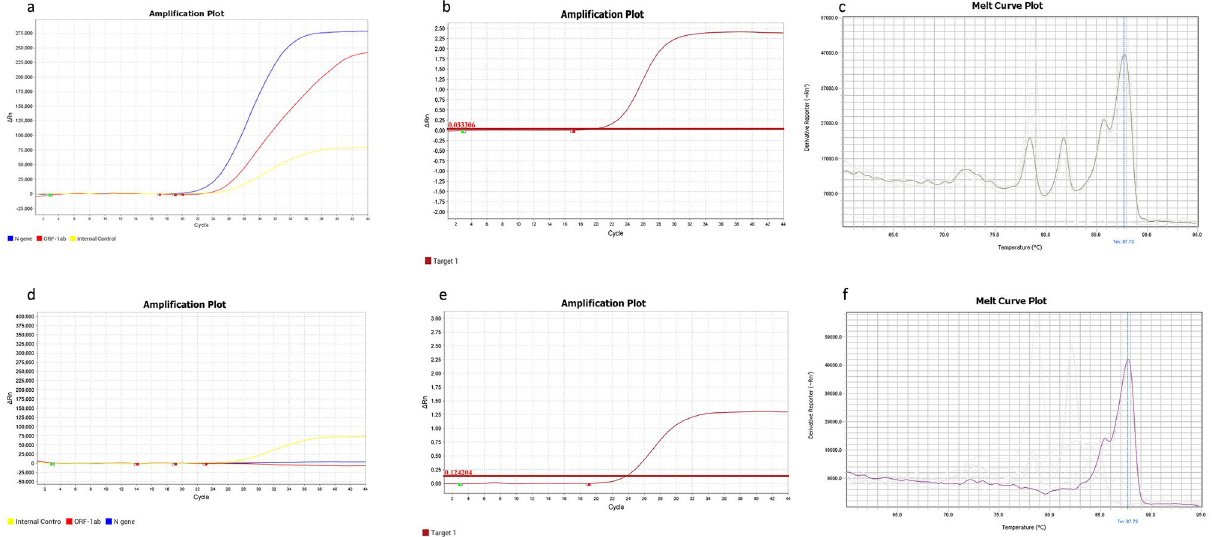
Figure 4. RT-PCR results for both assays. ( a ) Positive result for TaqMan Based method; ( b ) positive result for N, E and β-Actin genes in SYBR Green Based Method (linear View of fluorescence); ( c ) positive result for N, E and β-Actin genes in SYBR Green Based Method (Melt curve plot) ( d ) negative result for TaqMan Based method (only Internal control peak); ( e ) negative result for SYBR Green Based Method (linear View of fluorescence); ( f ) negative result for SYBR Green Based Method (Melt Curve Plot); Target 1 in sub-figure ( b ) and ( e ) denotes N + E + β-Actin where the reporter is SYBR. In sub-figure, ( a ) and ( d ), the blue, red and yellow color denote the N gene, ORF1ab gene and Internal control specific probe,